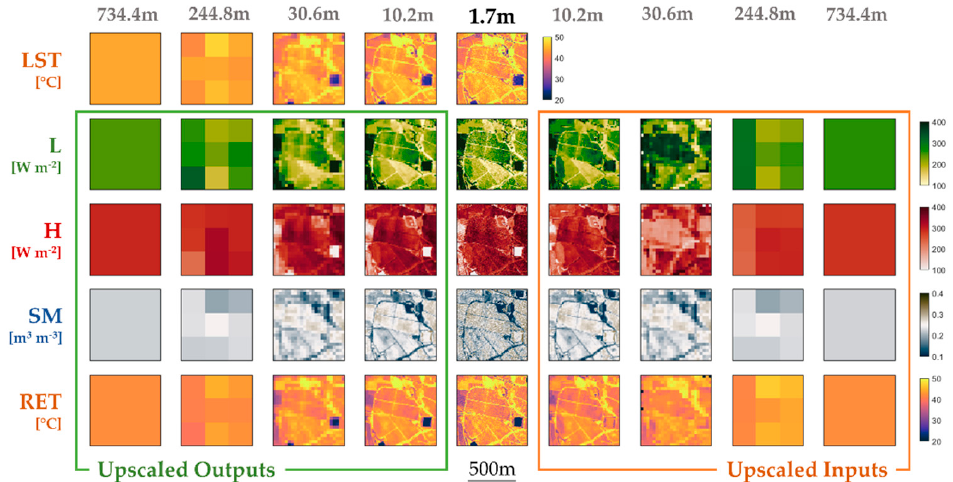
Figure 8. Overview of Land Surface Temperature (LST) and four FEST-EWB outputs across the selected scales and the two aggregation approaches: Latent Heat (L), Sensible Heat (H), Soil Moisture (SM) and Representative Equilibrium Temperature (RET).